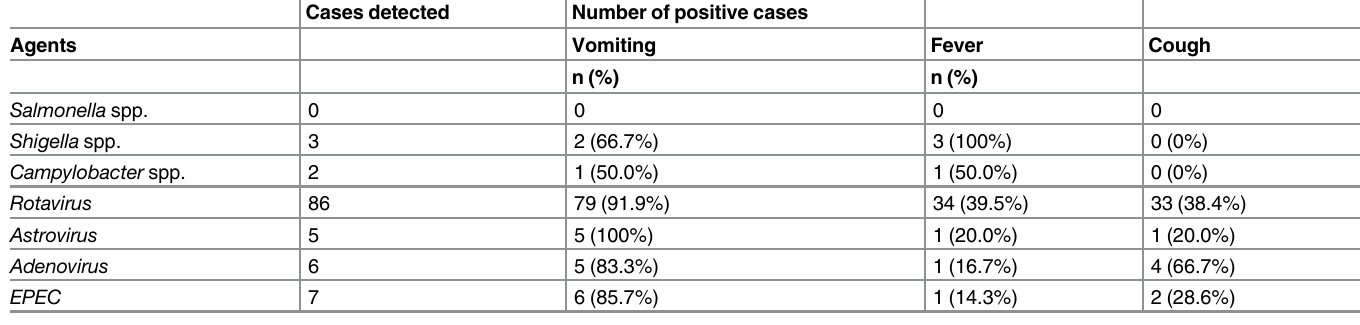
Table 2. Clinical symptoms associated with the enteric pathogens isolated from children with diarrhea in Antananarivo and Moramanga, 2011 – 2014. Cases detected Number of positive